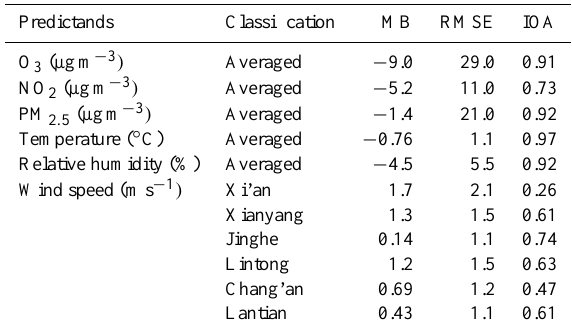
Table 3. Statistical comparison of simulated and measured O 3 , NO 2 , PM 2 . 5 , temperature, relative humidity, and wind speed at monitoring sites from 22 to 24 August